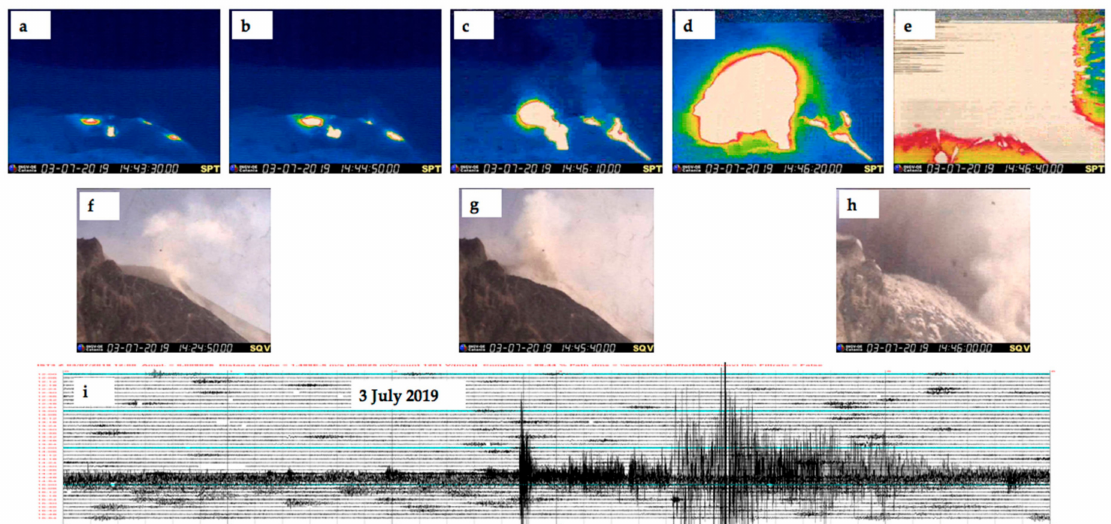
Figure 4. ( a – e ) Thermal images from the SPT camera showing the summit vents on 3 July 2019 at 14:43:3000 ( a ), at 14:44:5000 ( b ), at 14:46:1000 ( c ), at 14:46:2000 ( d ) and at 14:46:4000 ( e ), with ( a – c ) the emission of the intracrater lava flow from the CC vent and ( d , e ) the start of the jet explosion, view from S. Blue is cold, white is hot. ( f – h ) Visual images from the SQV camera showing ( f ) at 14:24:5000 the ash along the upper Sciara del Fuoco due to the lava flow output from the NEC, ( g ) at 14:45:4000 the eruptive plume, and ( h ) the fallout of bombs at 14:46:0000 along the upper Sciara del Fuoco, view from NE. ( i ) Seismic trace of the explosive event as recorded from the IST3 seismic station, Z component. See Figure 1 for station